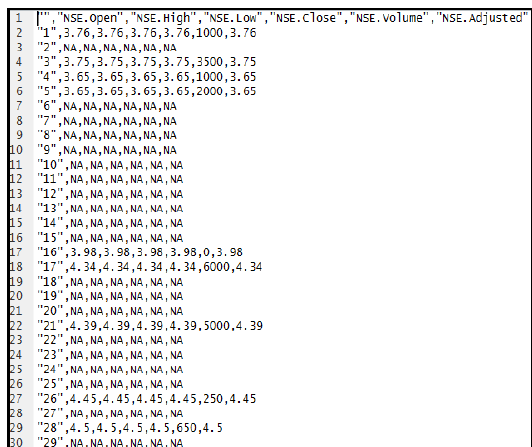
Figure 2. Data retrieved from the data source containing many null values